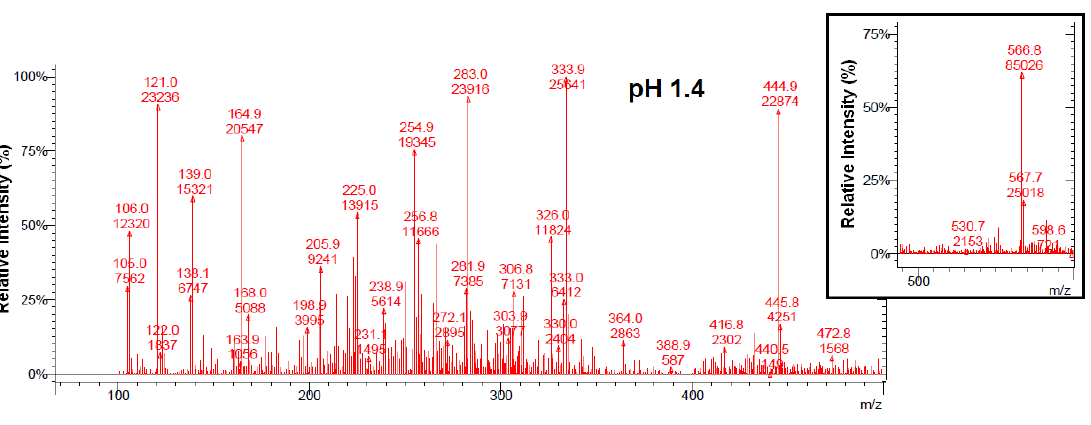
Fig. S6. Positive-ion ESI–MS spectrum for the complexes formed in the VOSO system at ligand-to-metal molar ratio 2:1, pH 1.4, C Explanation of the signals described in the text: m/z = 282.0 [VOL + fragment ion m/z = 78] + m/z = 283.0 [L + fragment ion m/z = 122 + Na + H] + m/z = 326.0 [VOL + fragment ion m/z = 122] + m/z = 567.0 [(VO) L + SO + NaOH + Na] + 2 2 4